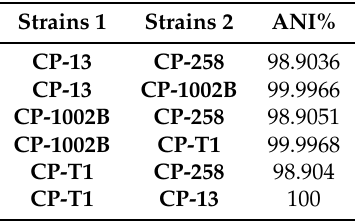
Table 2. Average nucleotide identity (ANI) similarity between the C. pseudotuberculosis